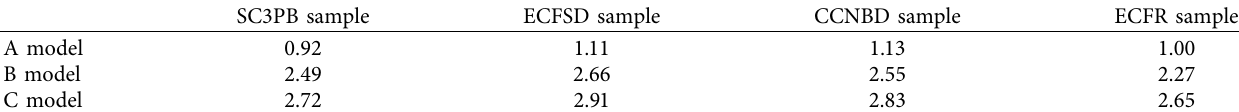
Table 5: Test results of fracture toughness (MPa · m 1/2 ).